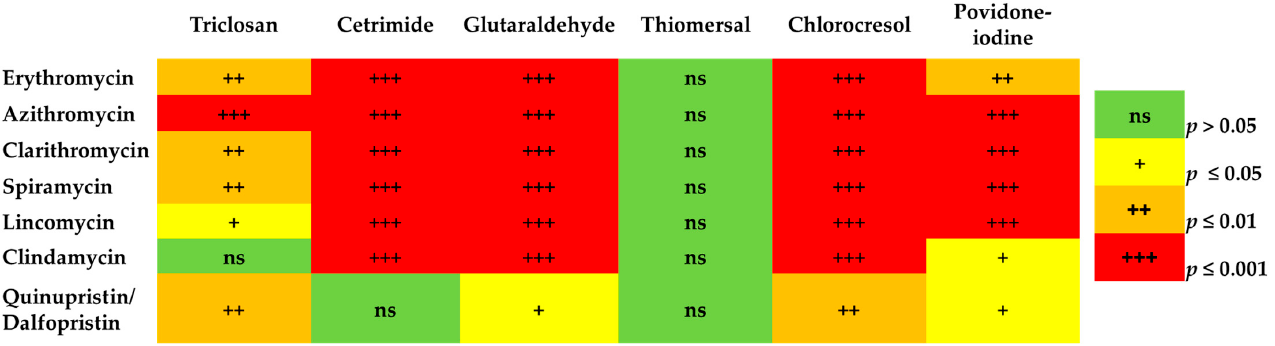
Figure 7. The Correlation between the reduced susceptibility to biocides and antibiotic resistance was calculated. Pearson’s correlation coefficients of pairwise comparison were employed to assess the correlation between MIC values for antibiotics and biocides of individual isolates, which showed MIC ≥ MIC 50 . There were significant correlations between the numbers of resistant isolates to antibiotics and the number of isolates with increased susceptibility to all biocides except thiomersal.